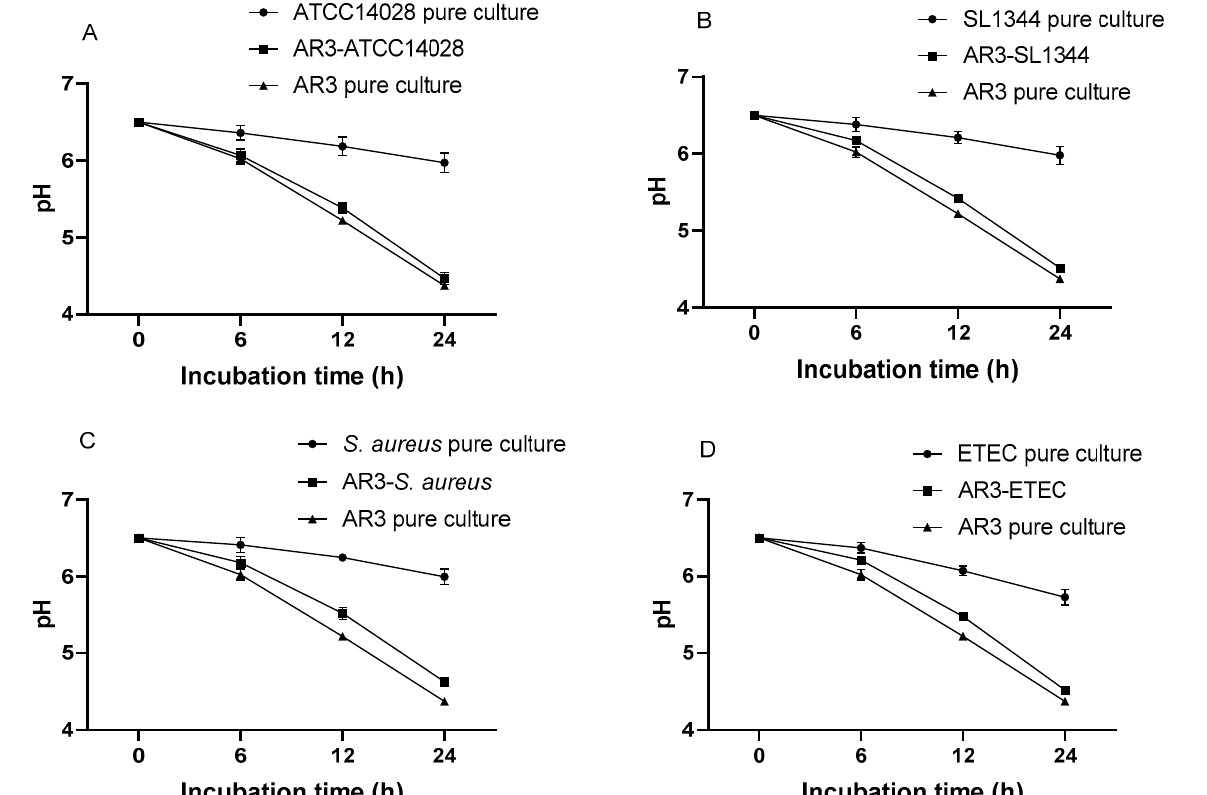
Figure 10. pH decline patterns of pure cultures of L. acidophilus AR3 and different pathogens, and co-cultures of L. acidophilus AR3 with S. Typhimurium ATCC14028 ( A ), S. Typhimurium SL1344 ( B ), S. aureus ( C ), and ETEC ( D ).